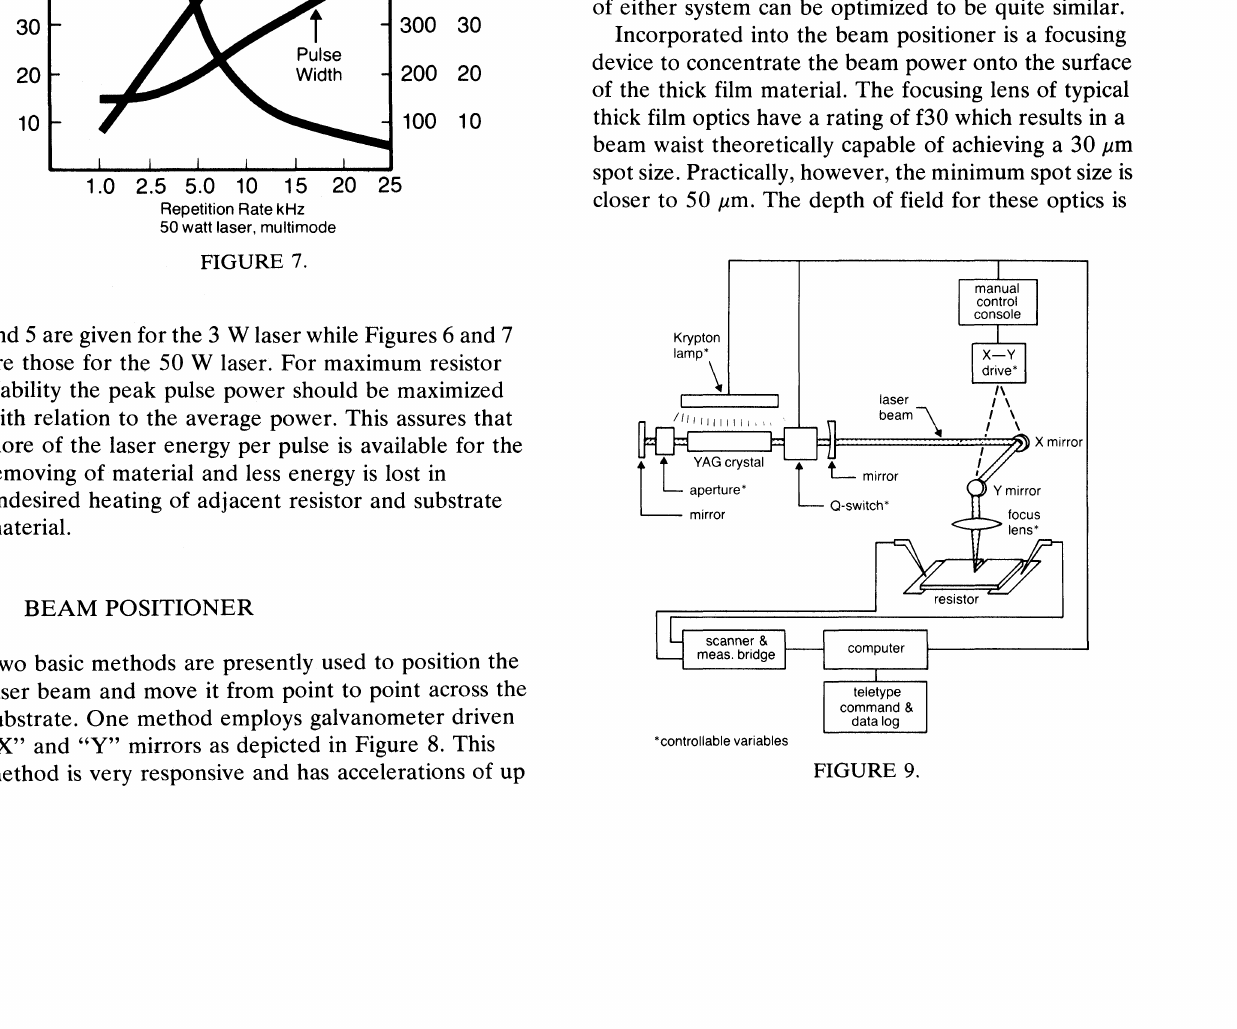
FIGURE 8 Galvanometer driven "X" + "Y"